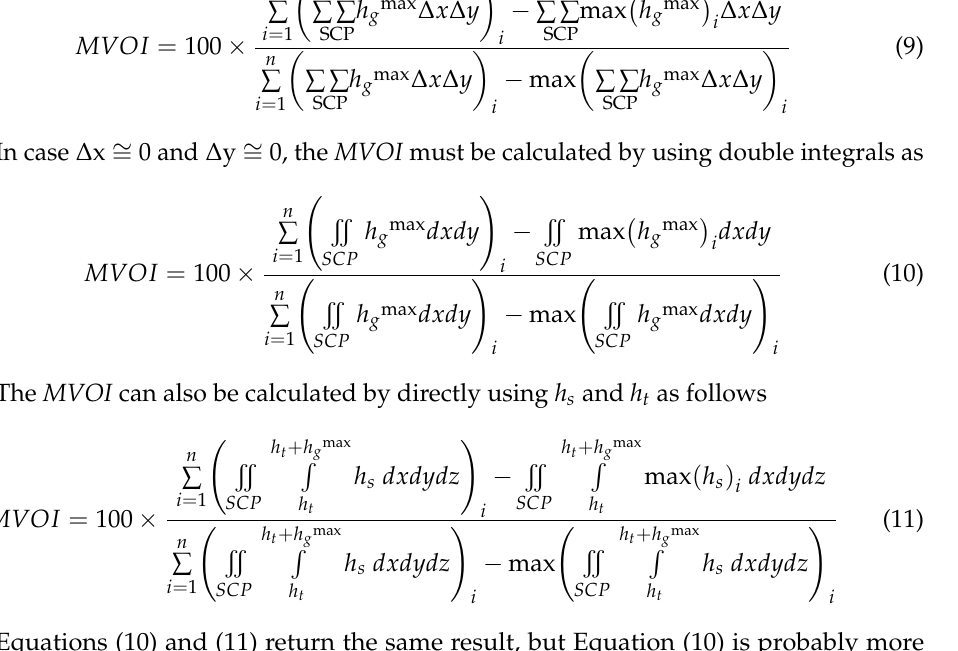
Figure 3. Violin plots showing the probability density of the heights above ground level (Y-axis) of the GPS points of each lesser kestrel. The box plots inside the violin plots show median (horizontal line inside the box) and the 25–75 percent quartiles. IDs are the same as those in Table 1. Table 2. Pairwise comparisons between the statistical distributions of bird heights above ground level by using a two-sample z-test. The table shows the pairwise z-values along with statistical sig- nificance. Tests were considered to be significant for (two sided) p < 0.05. Z-Statistics